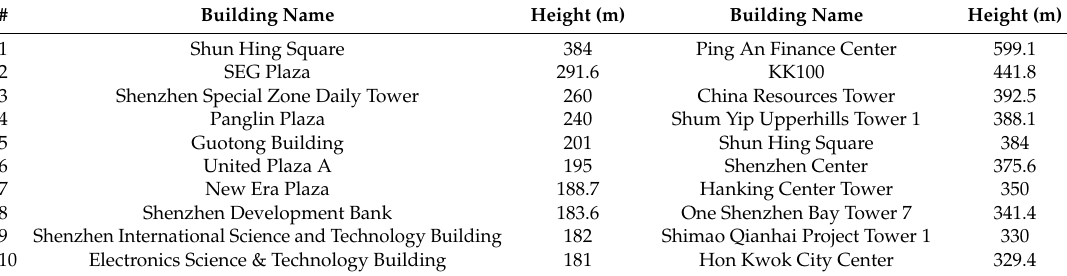
Figure 5. Shenzhen in 2000 and 2020. Table 15. Shenzhen’s 10 tallest skyscrapers in 2000 and 2020.